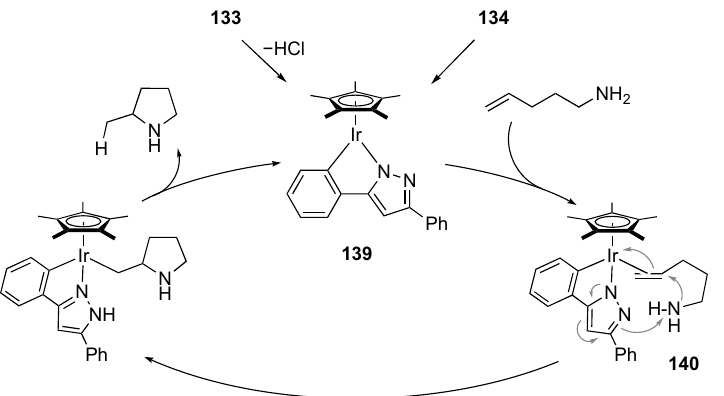
Scheme 53. Proposed mechanism for cyclization of aminoalkenes catalyzed by a protic pyrazole iridium complex. Substituents of aminoalkenes are omitted.